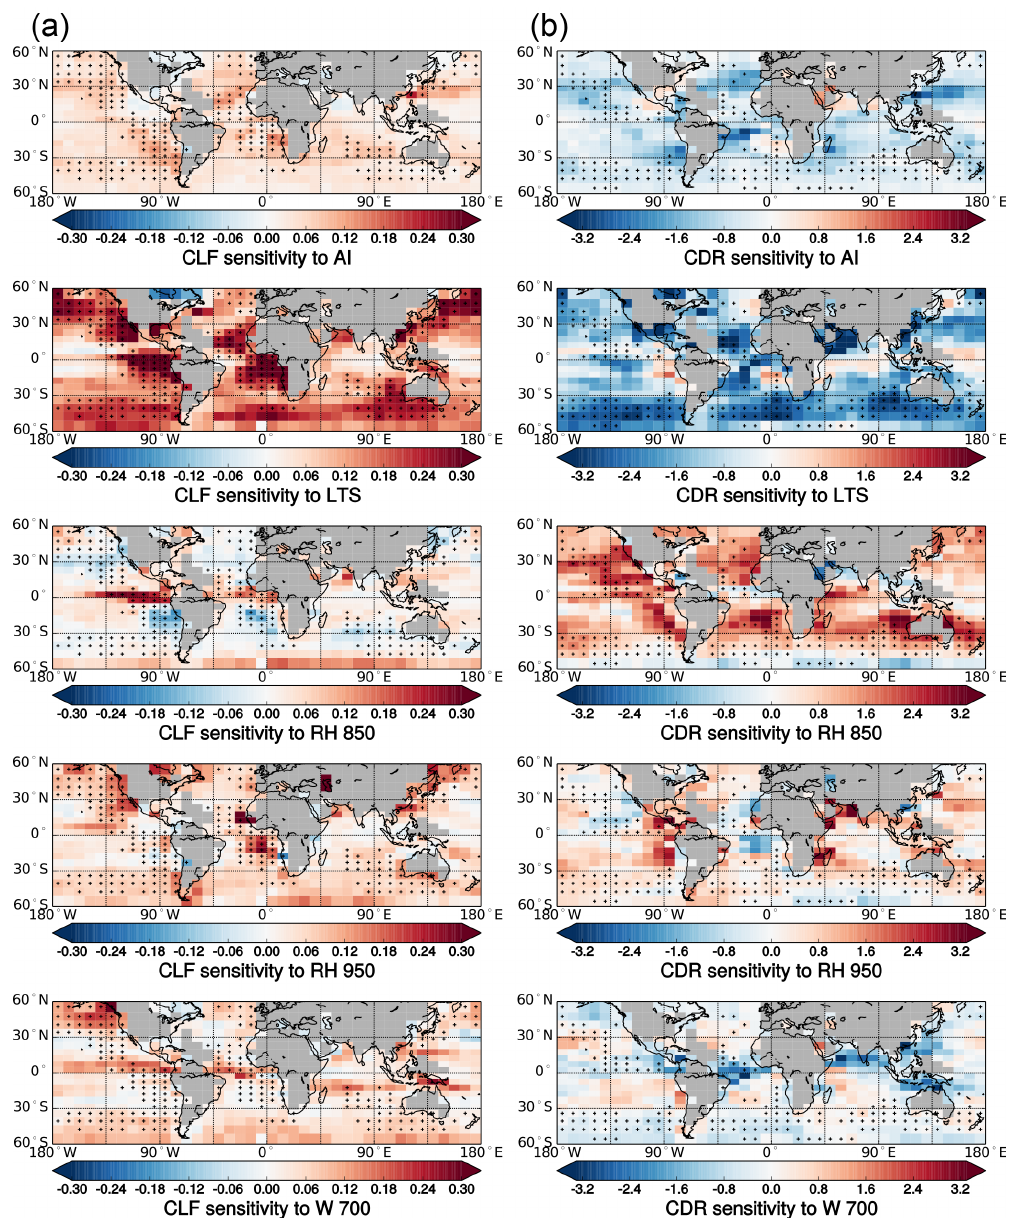
Figure 6. Global relative sensitivity patterns of selected CLF predictors Column (a) and CDR predictors Column (b) . Gray regions are either over land or do not contain at least 2000 data points. Regions where the ANN test skill ( R 2 ) is greater than 0.5 and rel. RMSE is less than its global average are marked with a “ +